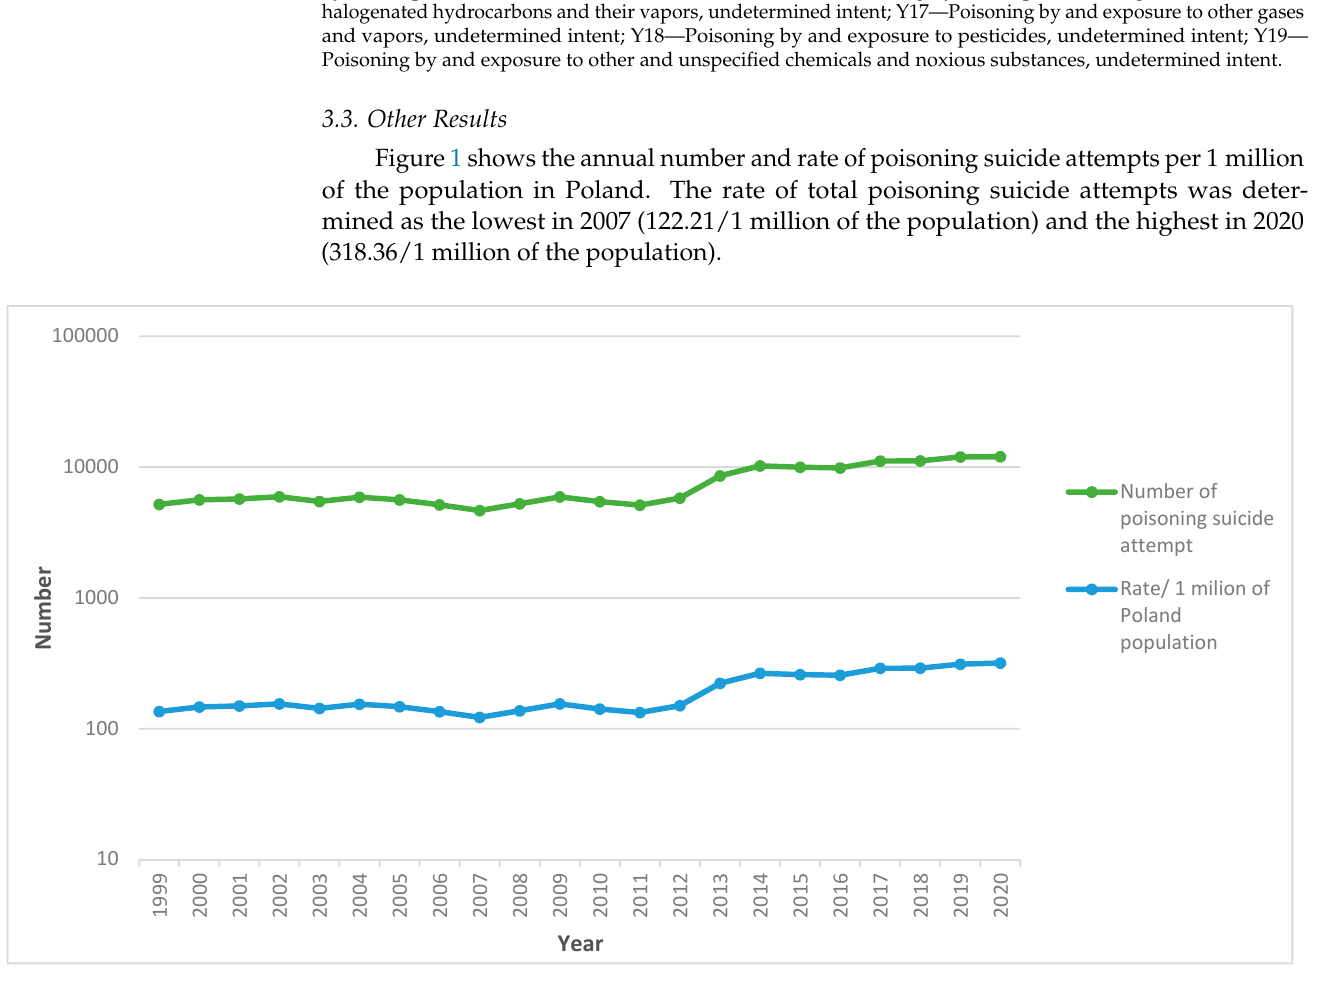
Figure 2. The numbers of suicide deaths and population rates caused by intoxication per 1 million of the population, Poland, 1999–2020 (source: own study). Note: The population of Poland was quite constant over the period of the study. Poland has a population of nearly 38 million people [18].